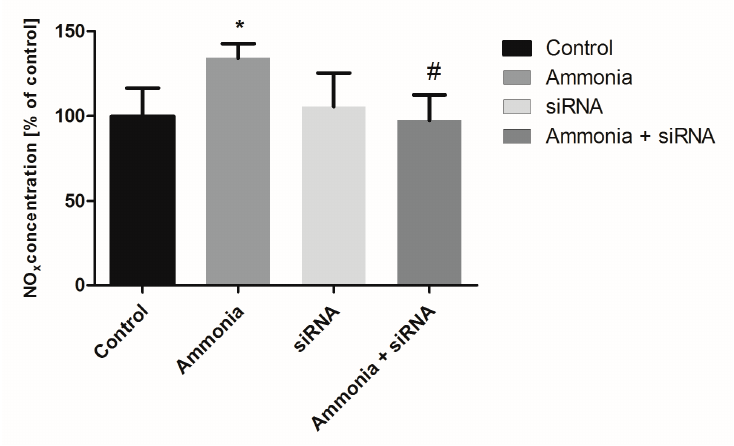
Figure 4. The effect of ammonia and Slc7a6 gene silencing on nitrite+nitrate (NOx) concentration in the medium derived from cultured astrocytes. Result are mean ± SD; n = 5, * p < 0.05 vs control, # p < 0.05 vs. ammonia.